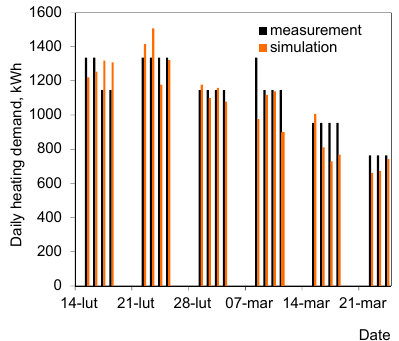
Figure 4. Measured and simulated daily heat demand in the school building. Energies 2018 , 11 , x FOR PEER REVIEW